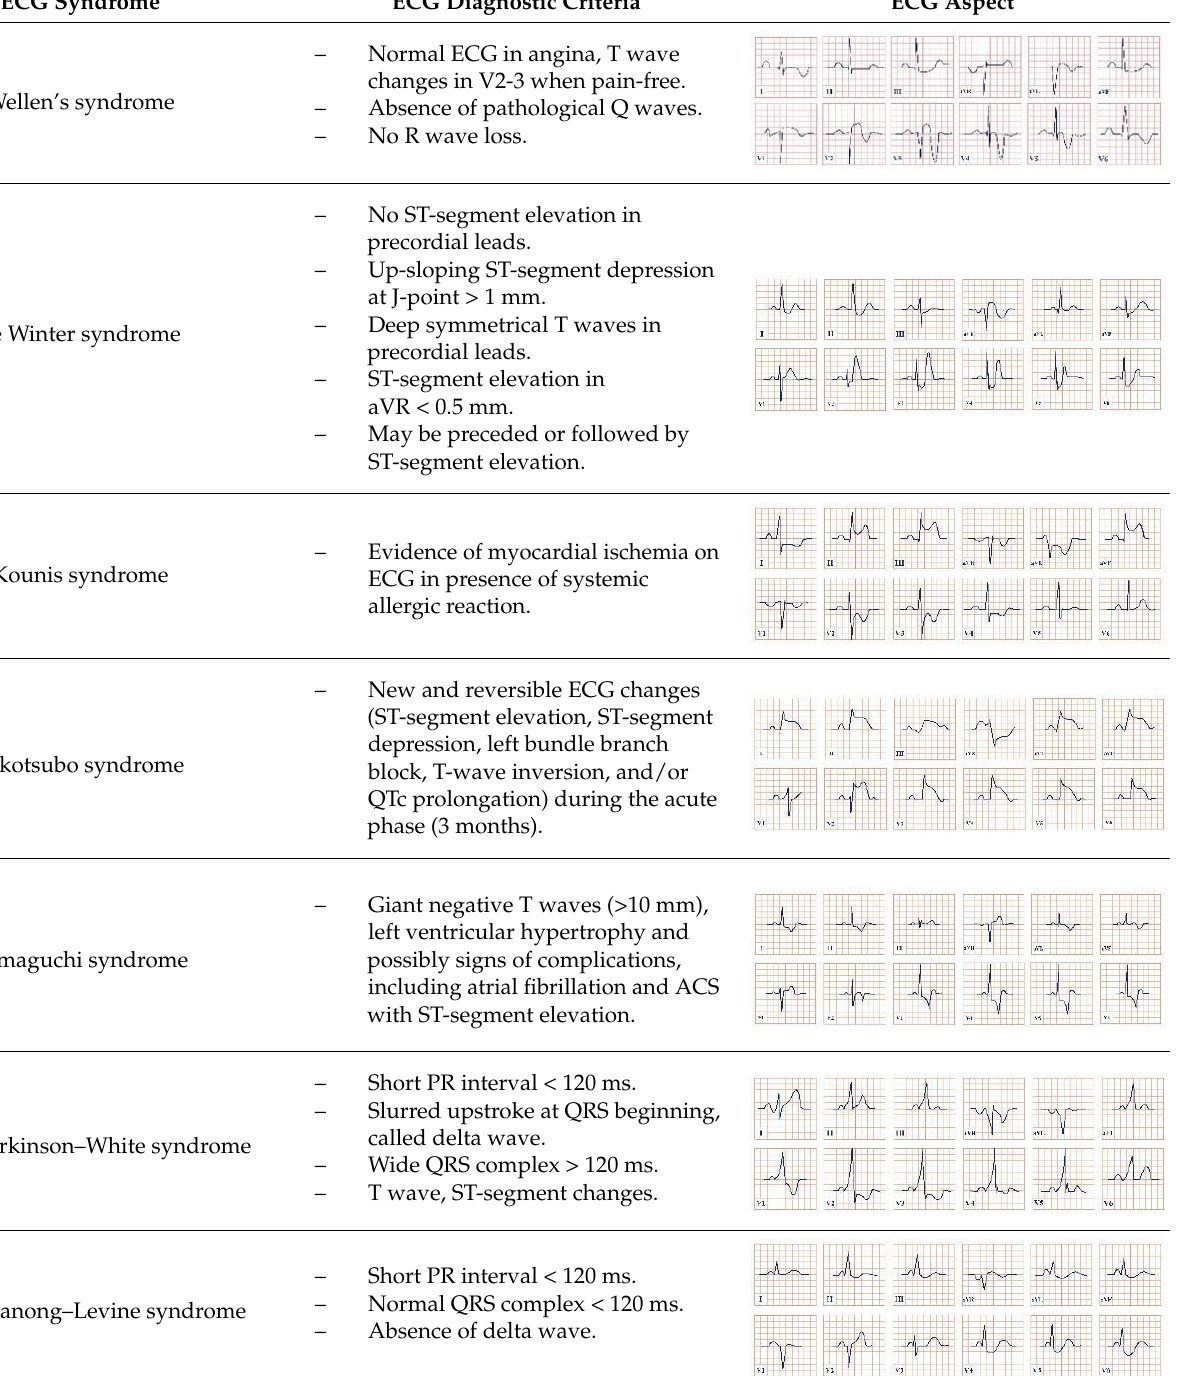
Table 1. Electrocardiogram syndromes.